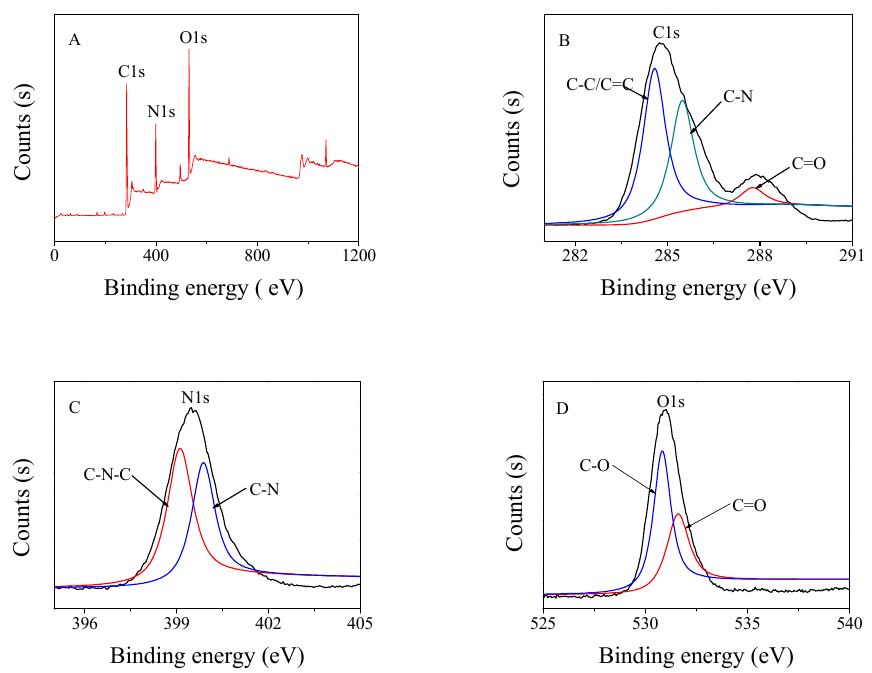
Figure 4. Survey XPS spectra of C-dots ( A ) and high-resolution XPS data of C1s ( B ), N1s ( C ) and O1s ( D ) of C-dots.